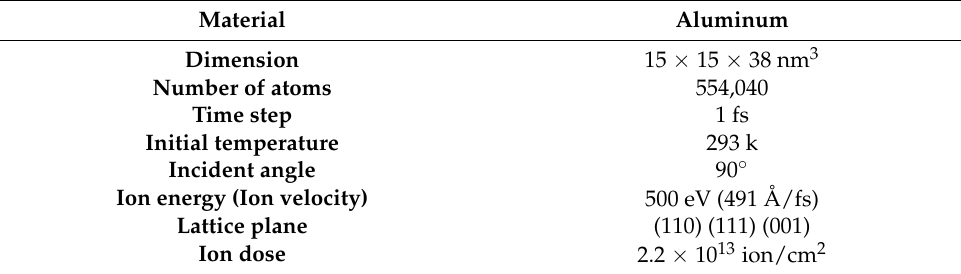
Table 1. Simulation parameters of ion beam sputtering.